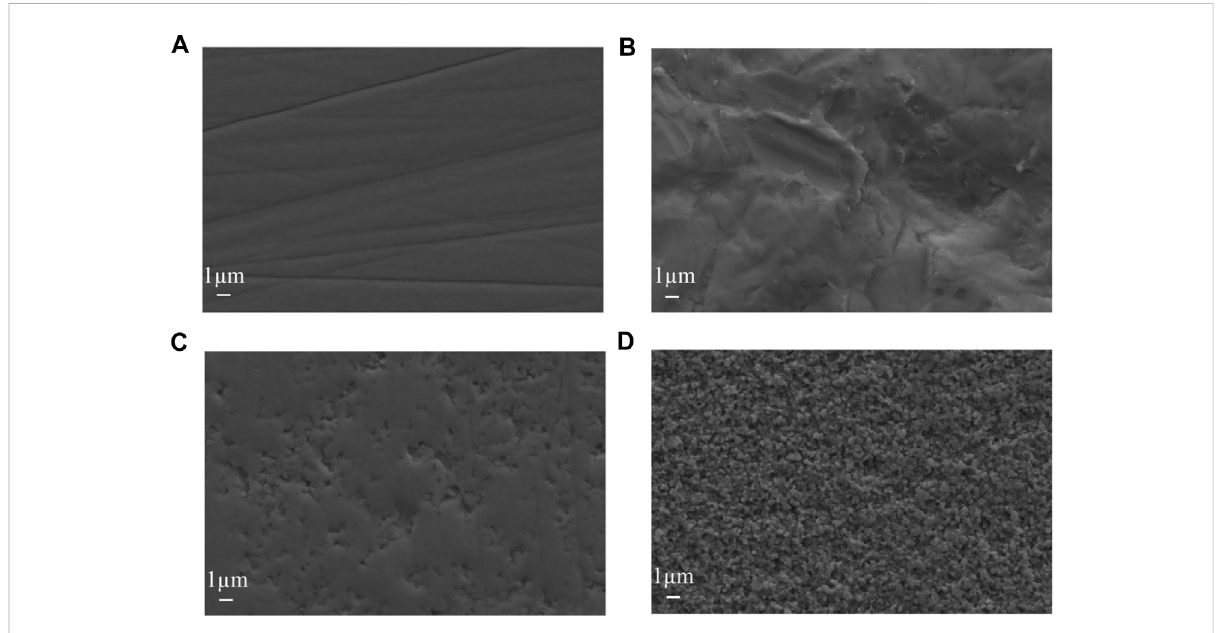
FIGURE 2 AFM observation images of zirconia specimens. (A) no treatment (B) sandblasting (C) hot etching with HCl (D) hot etching with HF.